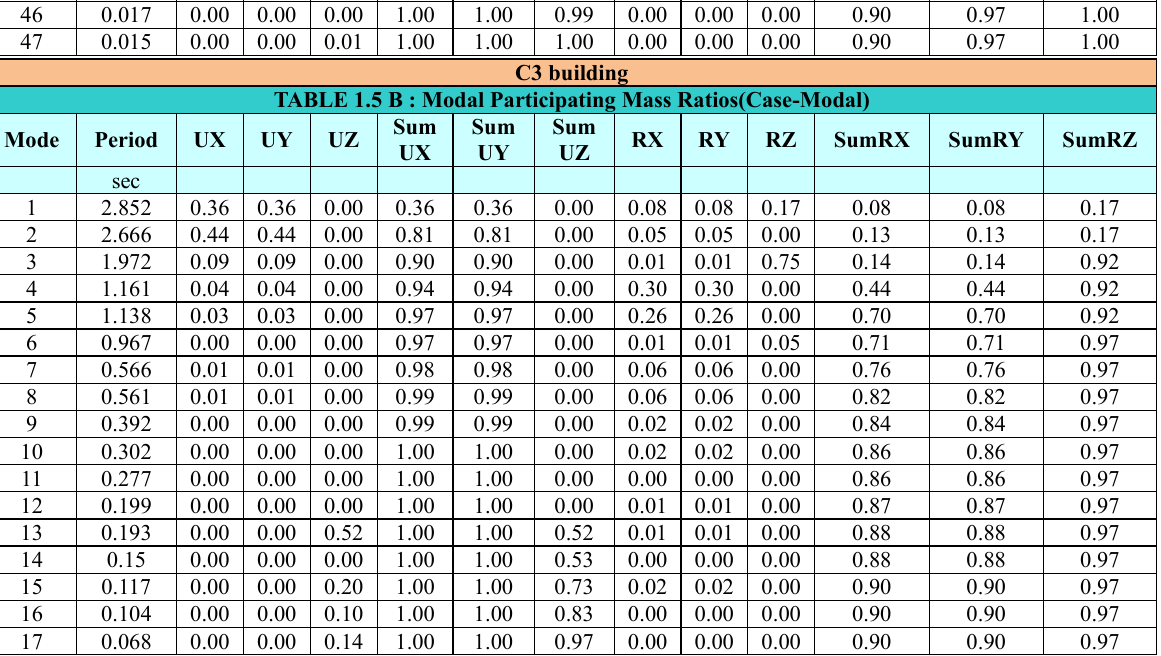
TABLE 1.5 B : Modal Participating Mass